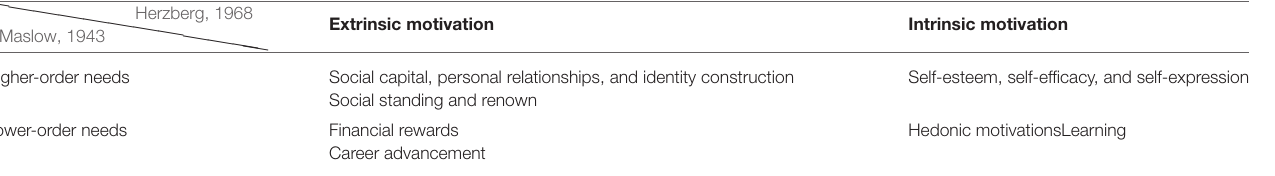
TABLE 3 | Integrative revision of classical motivational taxonomies and co-creation motivators. h hhhhhhhhhhh Herzberg, 1968 Extrinsic Maslow, 1943